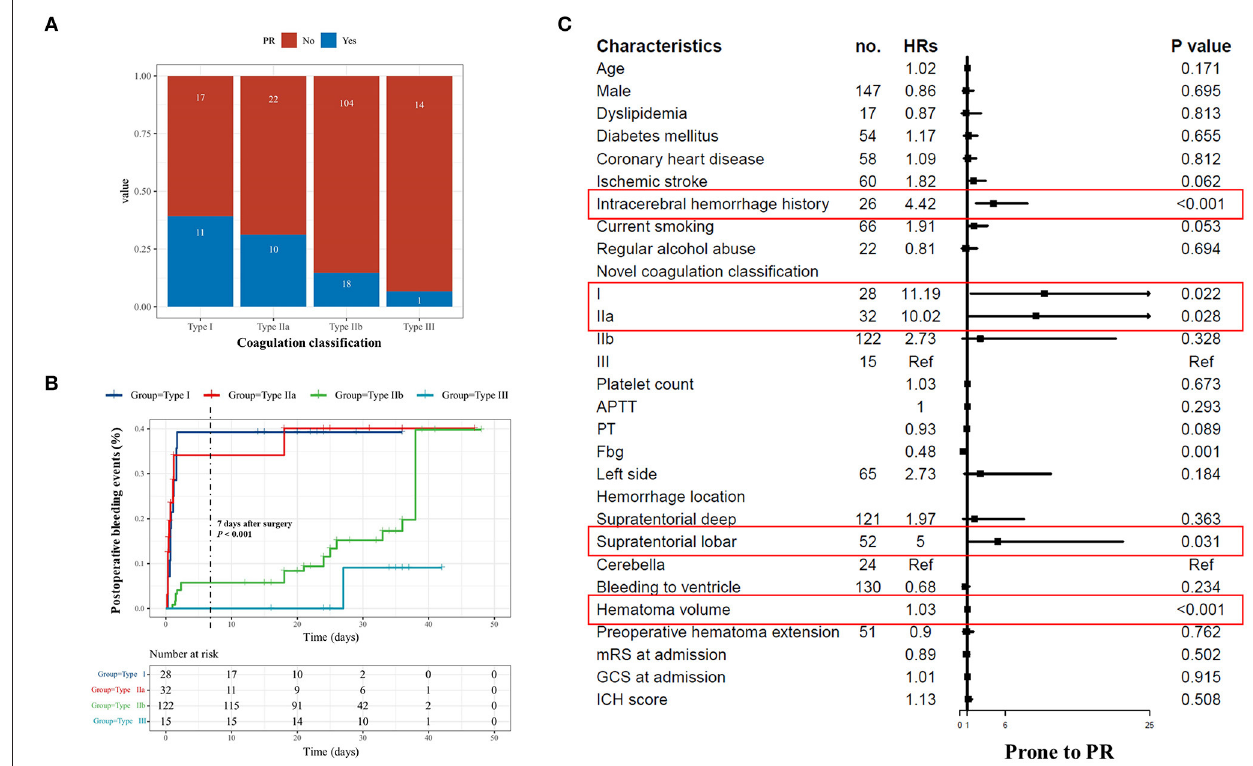
FIGURE 3 | Coagulation classification and postoperative rebleeding. (A) The number of PR in each coagulation classification. (B) The survival curve PR based on our novel coagulation classification is presented. The Type I patients had the highest risk of PR, followed by the Types IIa, IIb, and III. Within 7 days after surgery, the incident rate of PR was significantly higher in the Type I and Type IIa patients compared with the Type IIb and Type III patients. (C) The forest plot presented the result of univariate Cox regression analysis. The red frames suggest the significant parameters, which are then input into multivariate analysis. PR, postoperative rebleeding; NPR, no postoperative rebleeding; HR, hazard ratio; APTT, activated partial thromboplastin time; Fbg, fibrinogen.